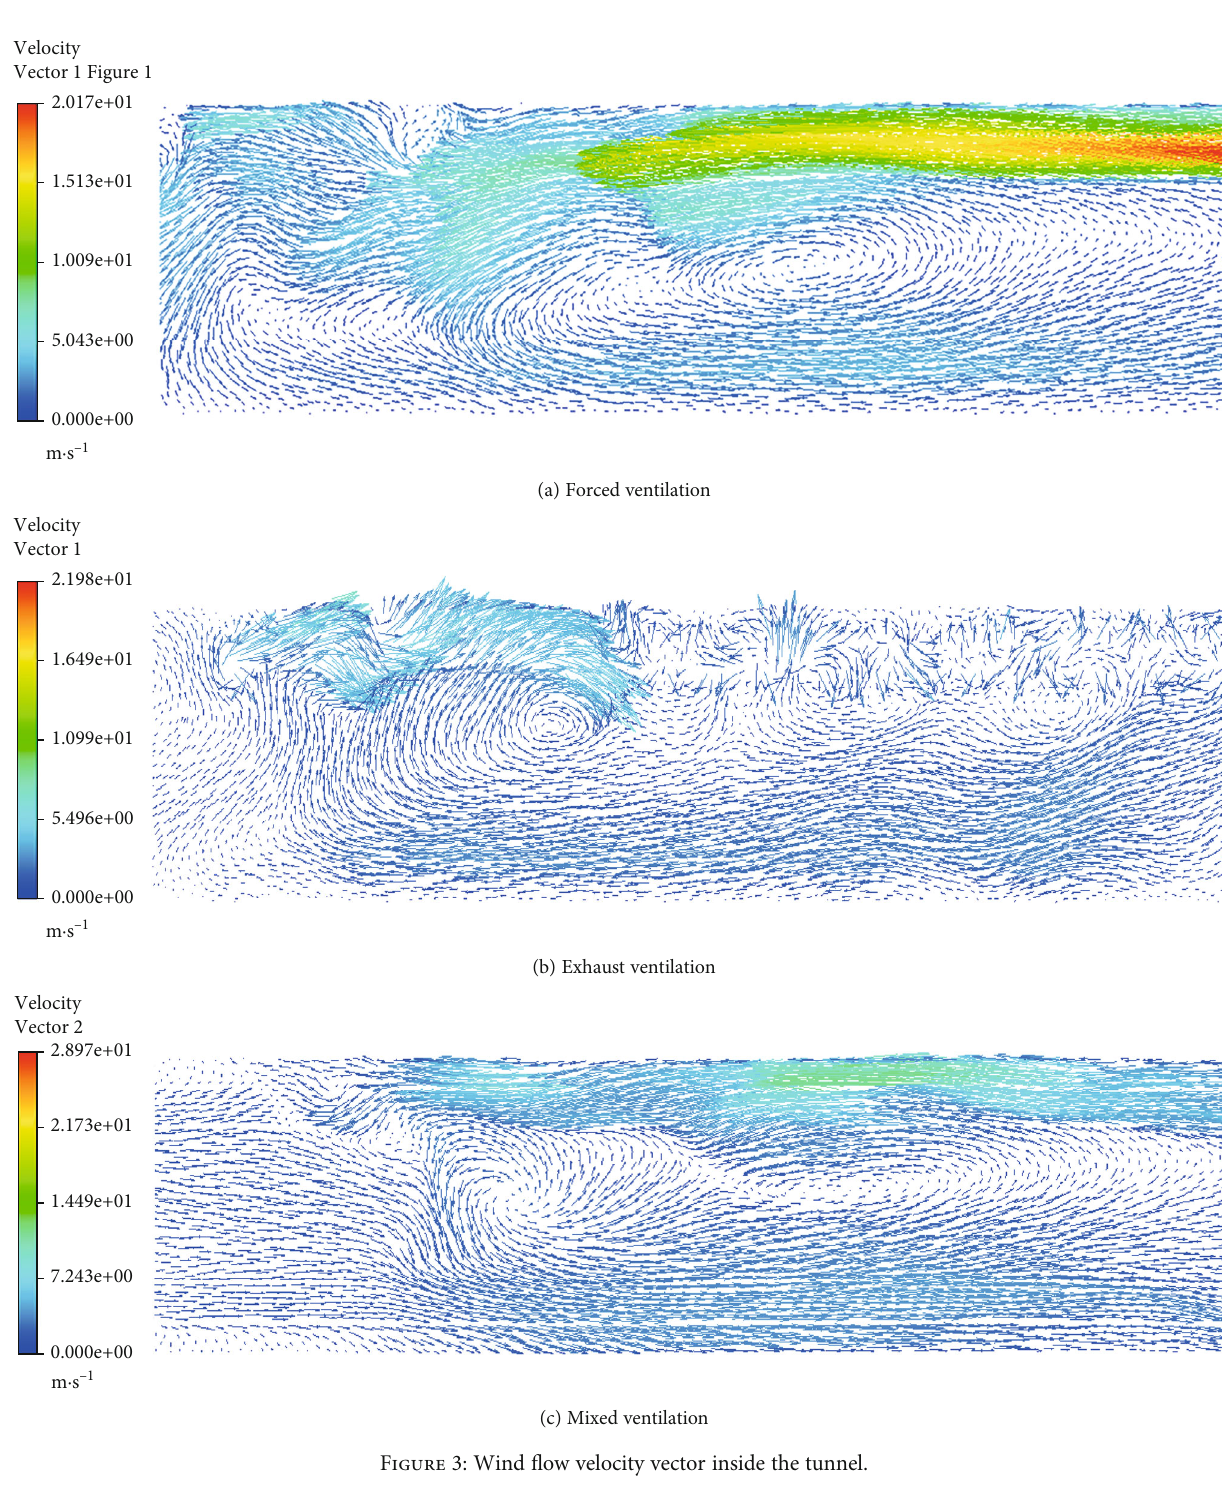
Figure 3: Wind fl ow velocity vector inside the